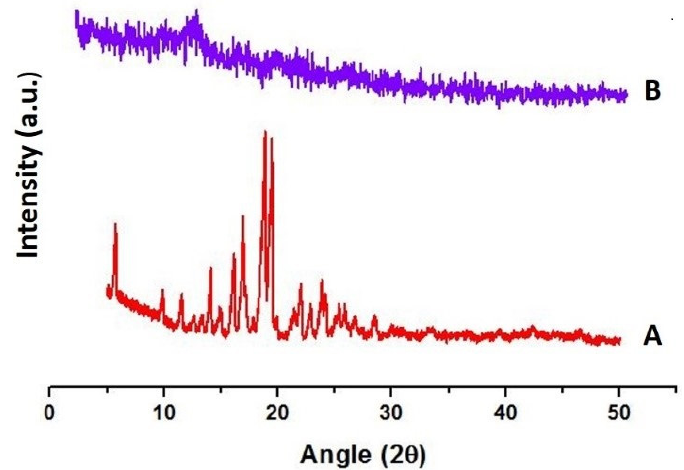
Figure 6. Powder X-ray diffraction of ( A ) EBT and optimized formulation ( B ) ETF-5.